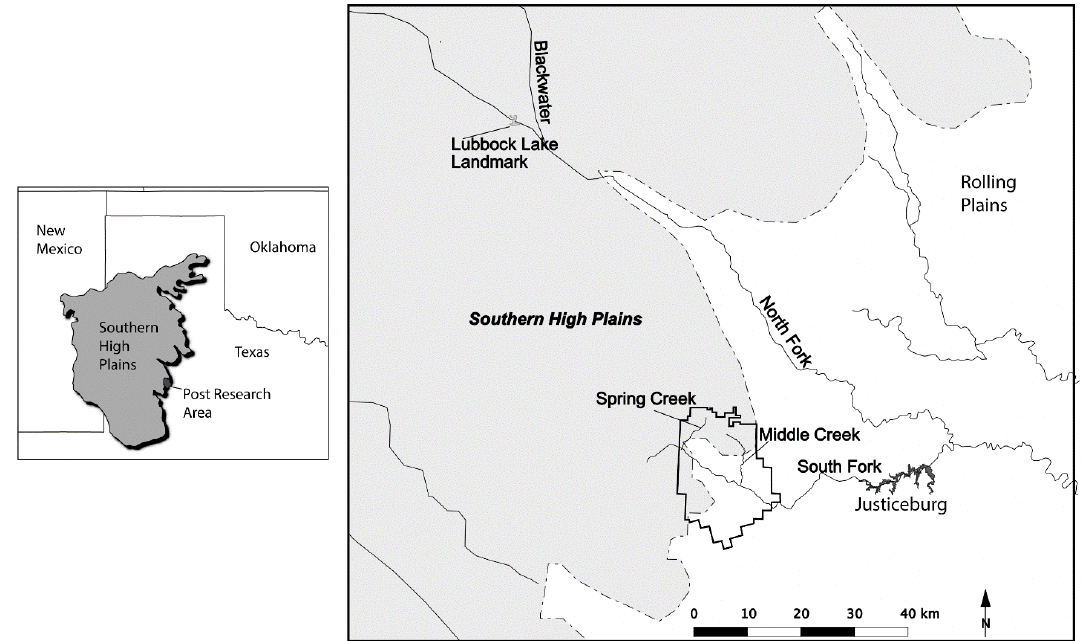
Figure 1. The Southern High Plains in northwestern Texas and eastern New Mexico (USA), highlighting the Post research area along the eastern escarpment into the westernmost Rolling Plains of